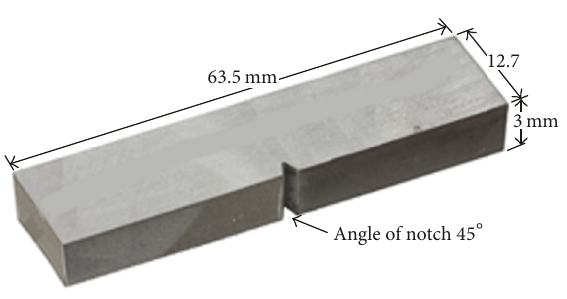
Figure 2: Dimensions of the impact testing sample.